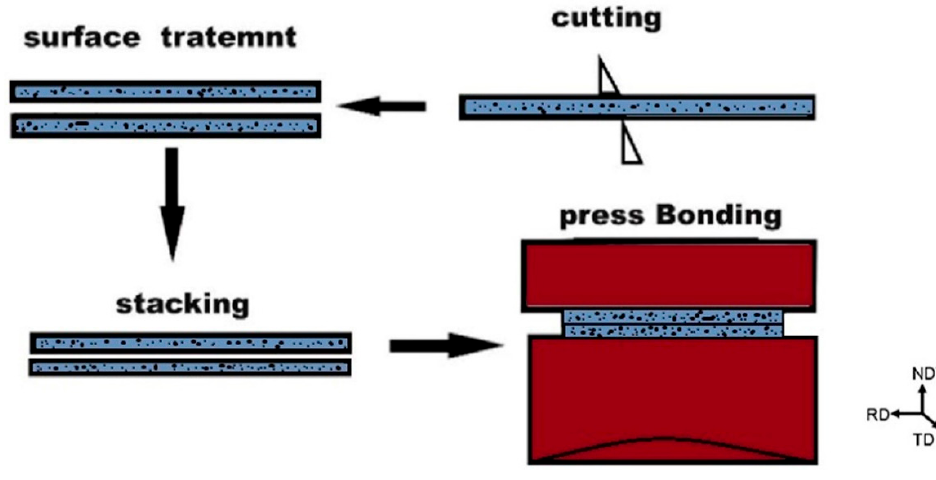
Figure 2. Diagram design of the APB.